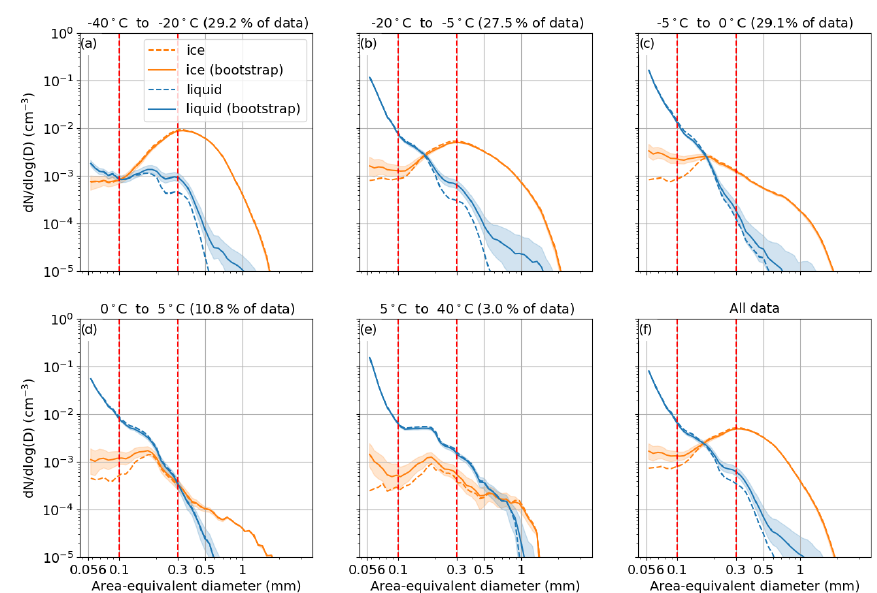
Figure 10. Particle size distributions are averaged over 1Hz data from SOCRATES flights RF01–RF14 and shown for six different temper- ature ranges. Dashed lines are deterministic predictions from UWILD. Solid lines and shaded areas are medians and interquartile ranges, respectively, for 30 bootstrapped samples generated from UWILD confidences. Red dashed lines separate the three different size classes.